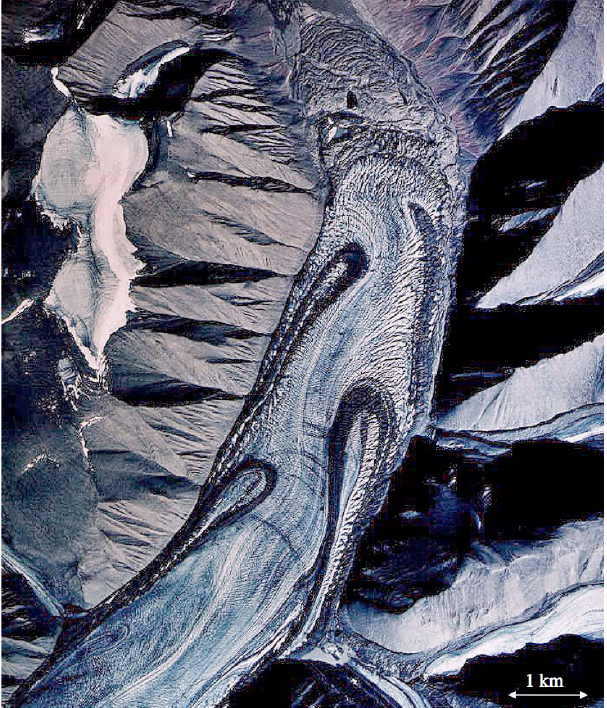
Figure 2. Moraine loops on the lower part of Abrahamsenbreen, formed by rapid displacement of terminal moraines from tributary glaciers during the surge of 1978 (aerial photograph S903134 1990; © Norsk Polarinstitutt)